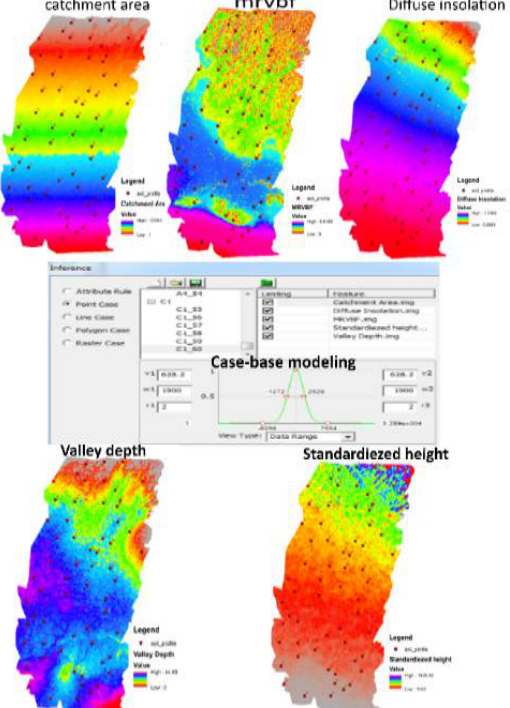
Figure 2. selected covariates and modeling in ArcSIE10.4